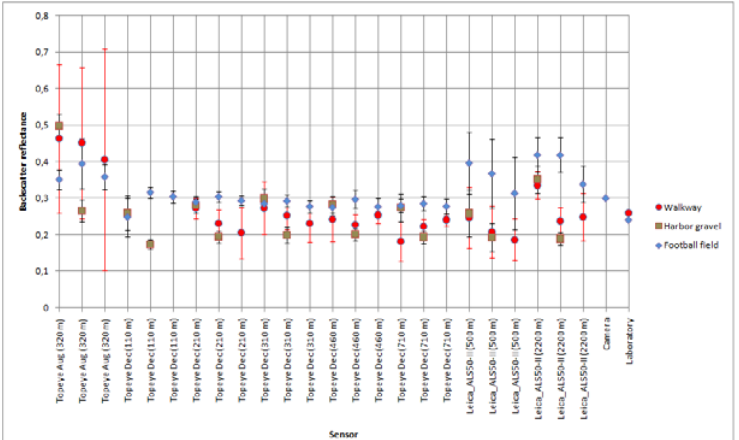
Figure 8A. Backscatter reflectance values of natural samples using parking lot asphalt as reference target. Standard deviation of the walkway is marked with red as the largest one. Backscatter reflectance for walkway, harbor gravel and football